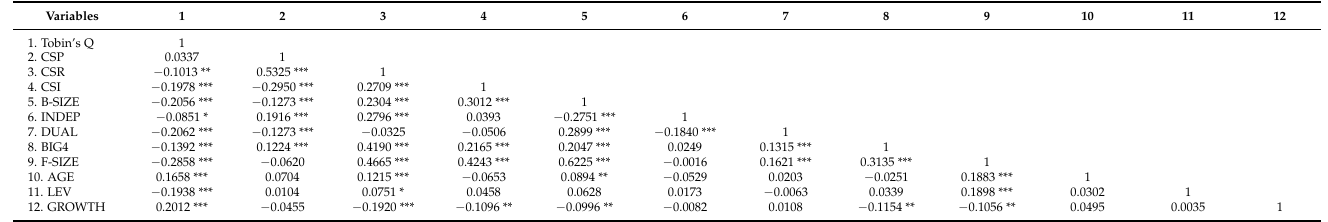
Table 3. Pearson correlation